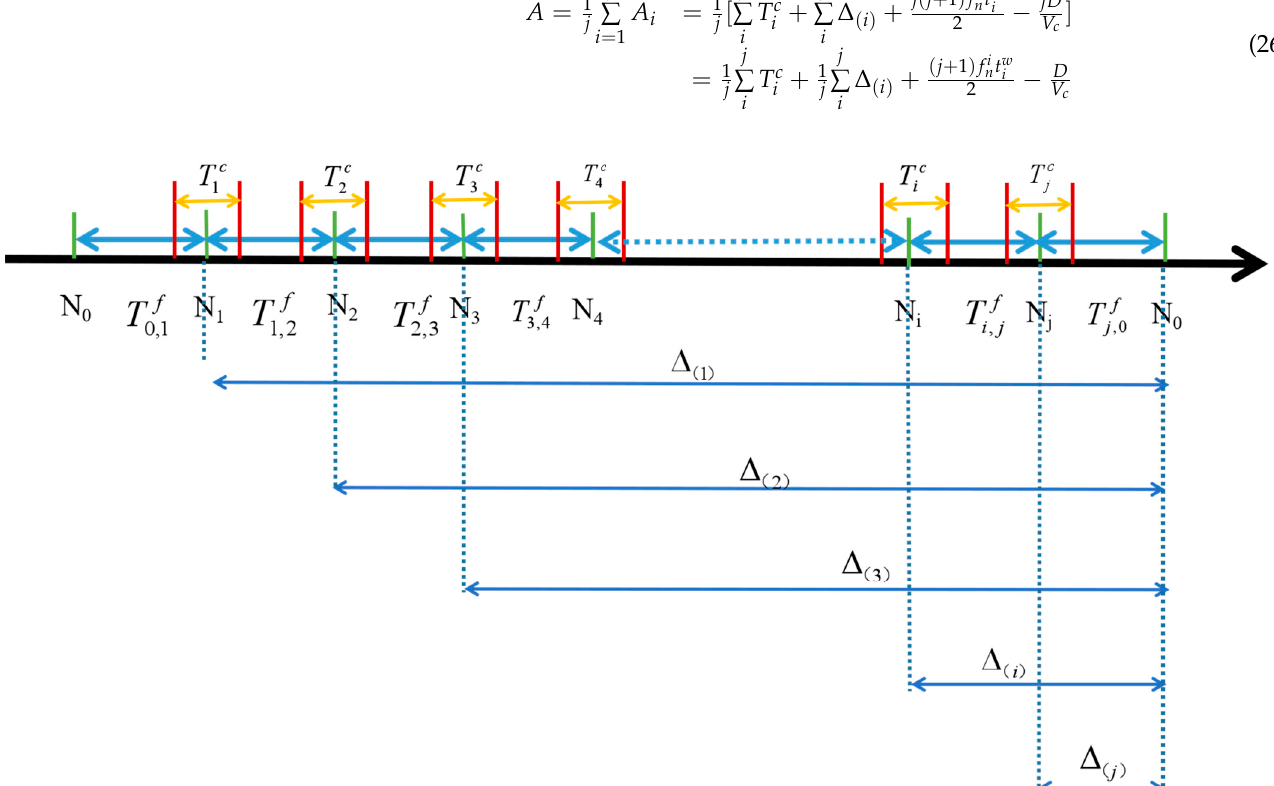
Figure 3. Sequence diagram of a data collection node by the UAV.